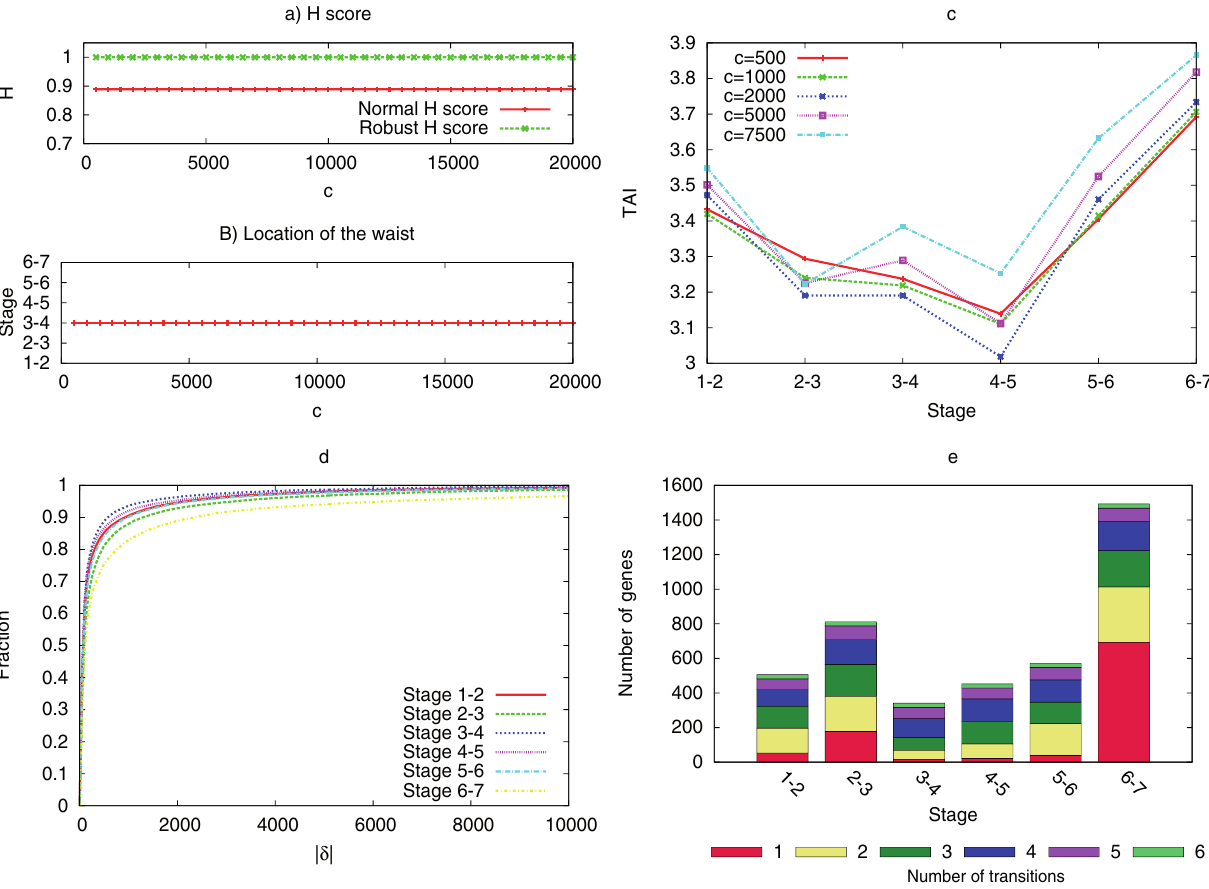
Figure S4. Arabidopsis thaliana results using absolute expression levels. Graph ( a ) shows the hourglass score (normal and robust) as a function of the transition threshold c . Graph ( b ) shows the location of the hourglass waist (stage-pair) as a function of the transition threshold c . Graph ( c ) shows the Transcriptome Age Index of transitioning genes for five different values of c (chosen so that the number of genes with known age index assigned to each stage-pair is at least 170). Graph ( d ) shows the CDFs of the expression level absolute variations | δ | across successive stage-pairs. Graph ( e ) shows the transitioning genes with c = 5000. The transitioning genes constitute 8% of all genes in that dataset. 48% of those genes transition in a single stage-pair. Of the remaining, 38% transition only in consecutive stage-pairs. [Dataset